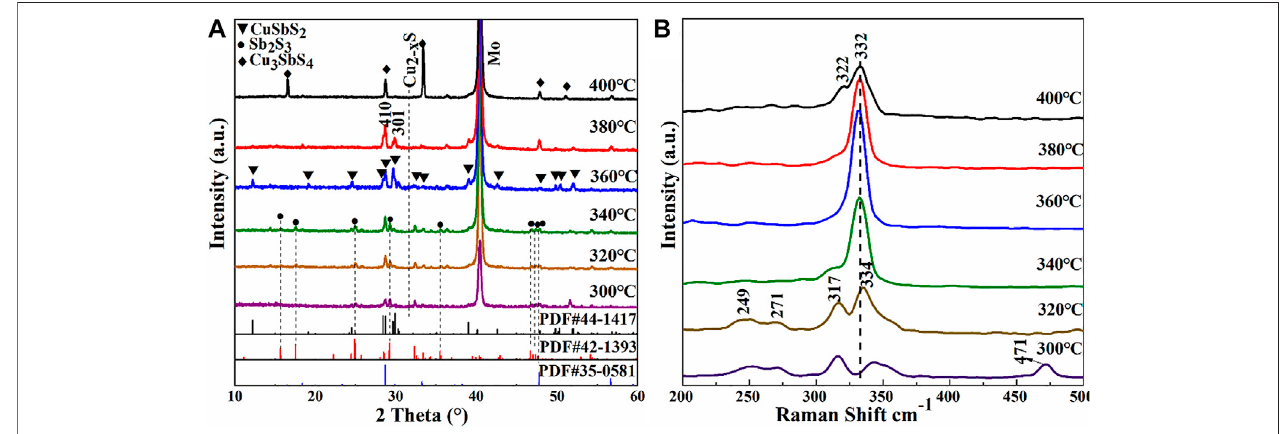
FIGURE 5 | (A) XRD patterns and (B) Raman spectra of CuSbS 2 thin fi lms sulfurized at different substrate temperatures: 300 ° , 320 ° , 340 ° , 360 ° , 380 ° , and 400 ° C.